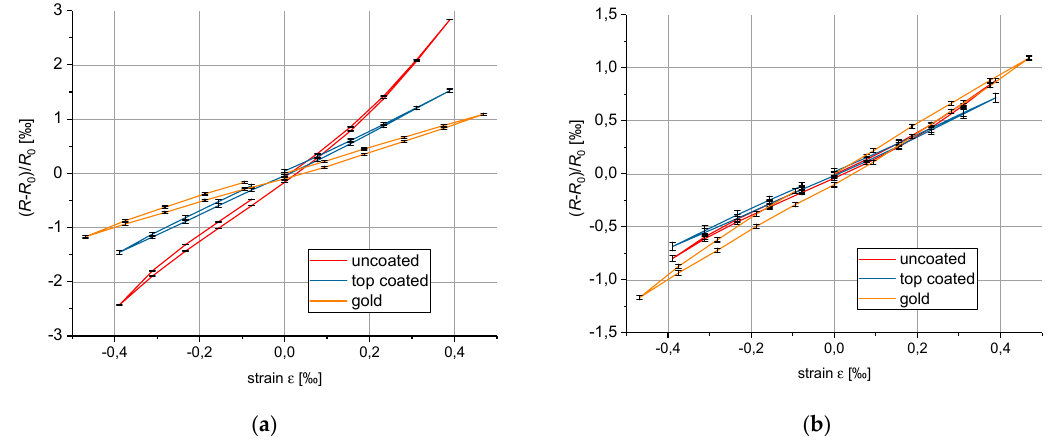
Figure 4. ( a ) Carbon-based strain gauges lose their nonlinearity after being top coated, but also the gauge factor decreases. Both measurements show a hysteresis effect, which is smaller than that for silver, though; ( b ) Silver-based strain gauges show a slight nonlinearity before top coating, which vanishes after application of the coating. Both measurements, however, show a hysteresis behavior for the gauge